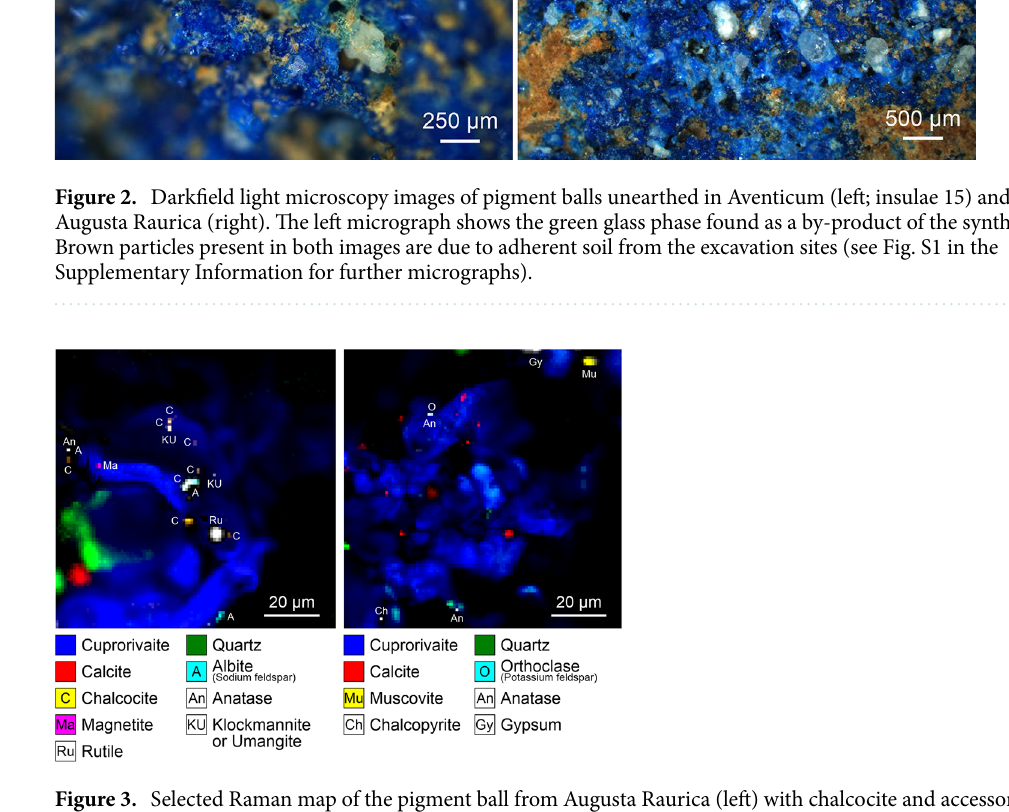
Figure 3. Selected Raman map of the pigment ball from Augusta Raurica (left) with chalcocite and accessories of the sulphidic copper ore. The paint layer of the mural fragment from the same excavation site (right) is contaminated with soil minerals, namely muscovite. This Raman map also contains the signature of disordered cuprorivaite, which is shown and discussed in detail in the Supplementary Information (Fig. S34; see Fig. S2 for further Raman